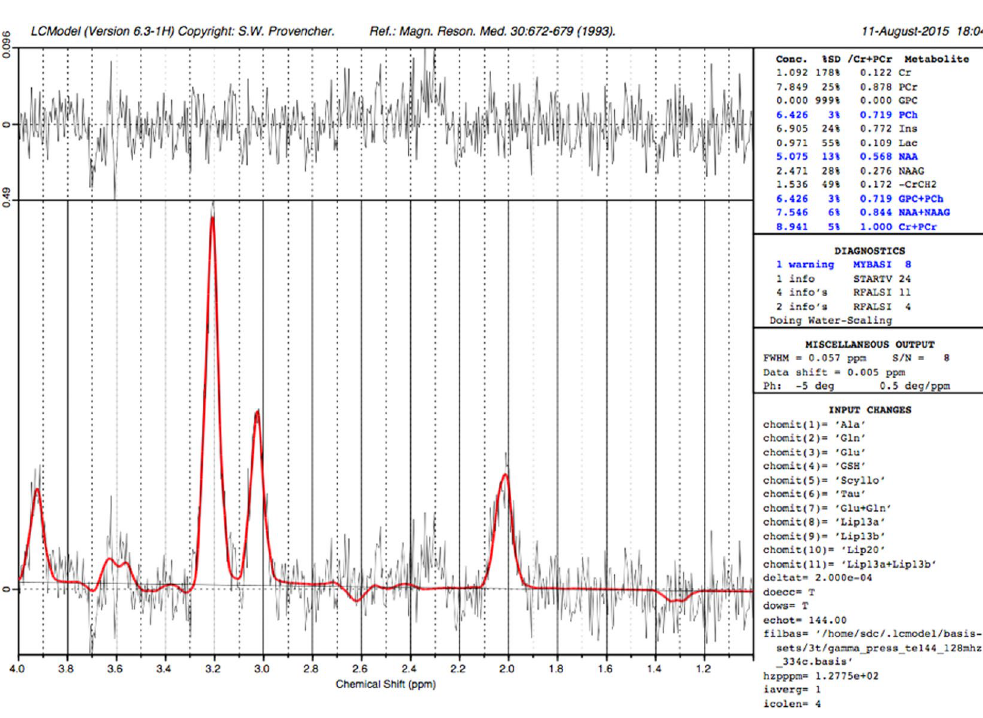
Figure 2. Typical good quality LCmodel spectra output obtained in a preterm infant at 38.14 weeks of